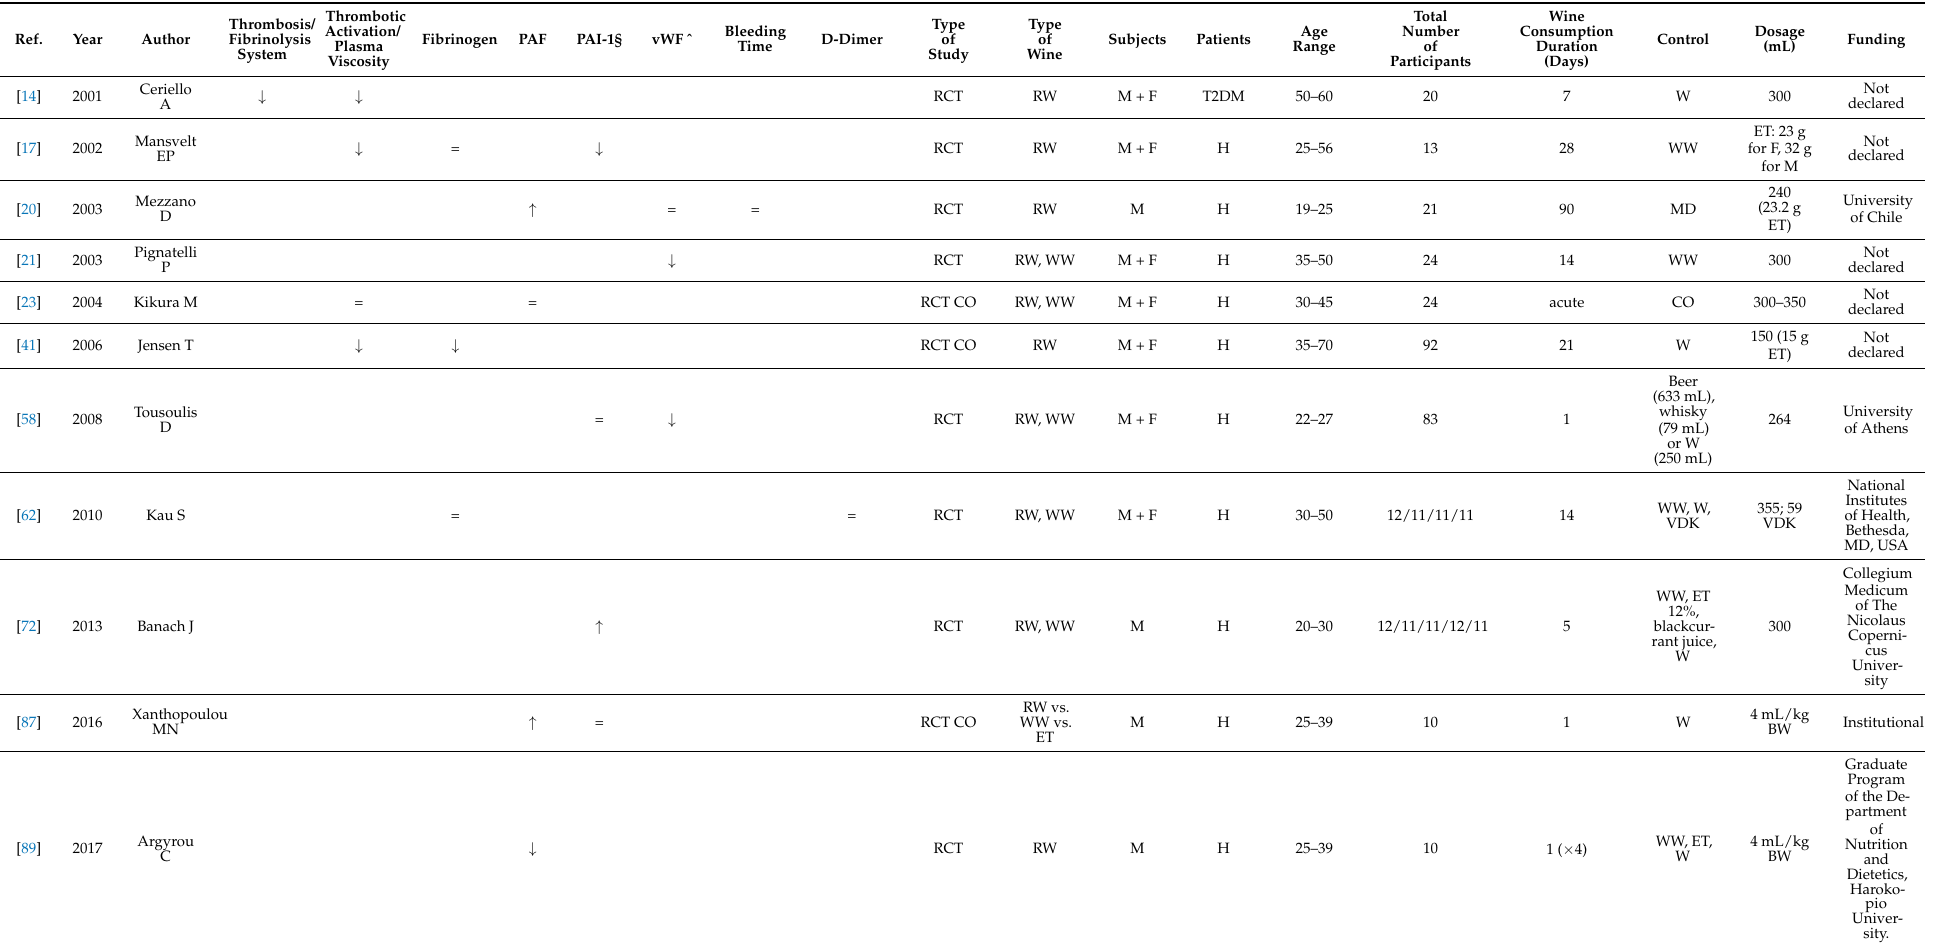
Table 3. Effects of red wine consumption on the coagulation pathway.